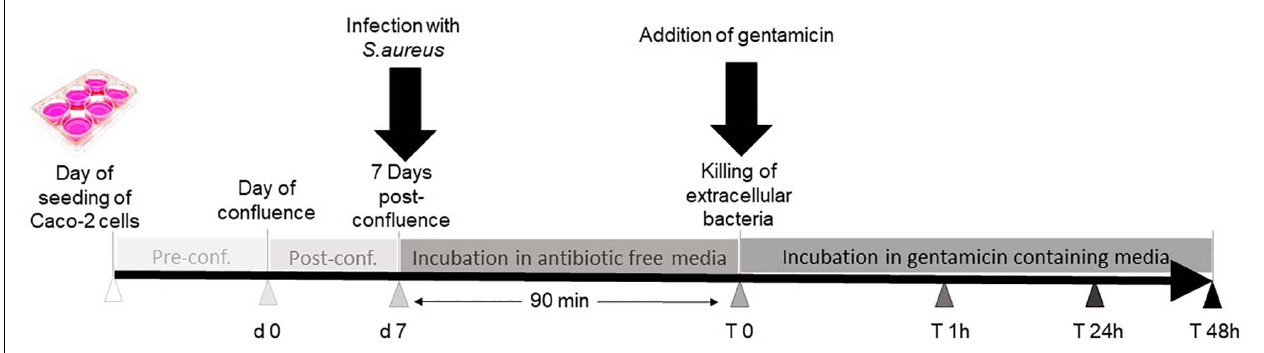
FIGURE 1 | Work follow summary. Caco-2 cells were seeded in six-well plates. Seven days post-confluence, three wells were infected with Staphylococcus aureus , and the other three wells were not infected and served as controls. Thereafter, the cells were incubated in antibiotic-free medium for 90 min to allow the bacteria to enter the cells before replacing the medium with gentamicin-containing media to kill extracellular bacteria. The cells were incubated further for 48 h and then harvested for further analysis.